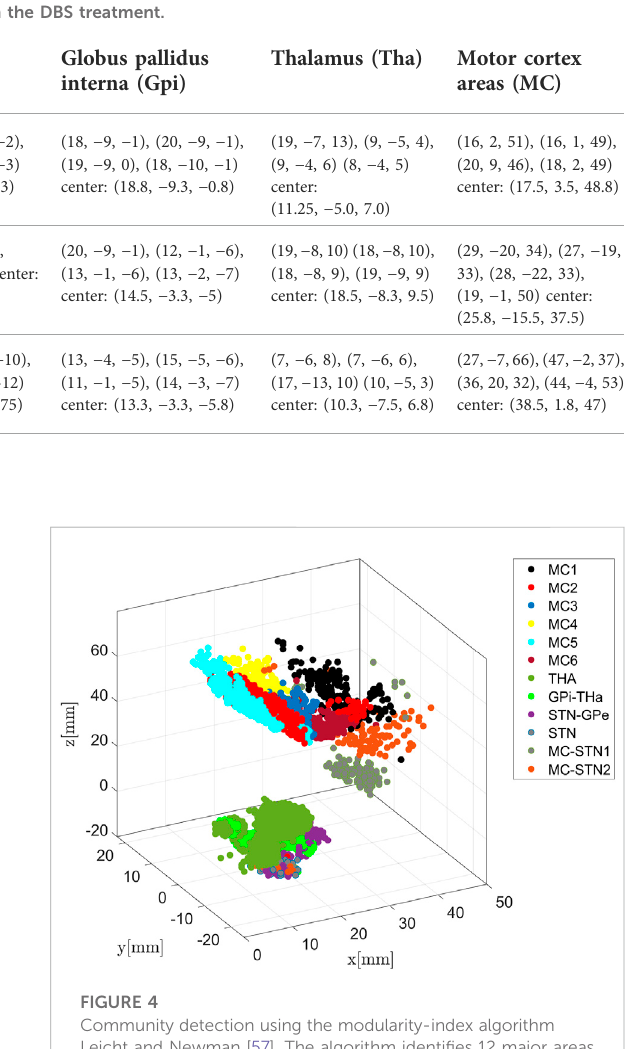
FIGURE 4 Community detection using the modularity-index algorithm Leicht and Newman [57]. The algorithm identi fi es 12 major areas with the number of members of densely connected communities higher than 100. Remarkably, the modularity partition generated by the simulation is in line with anatomical brain